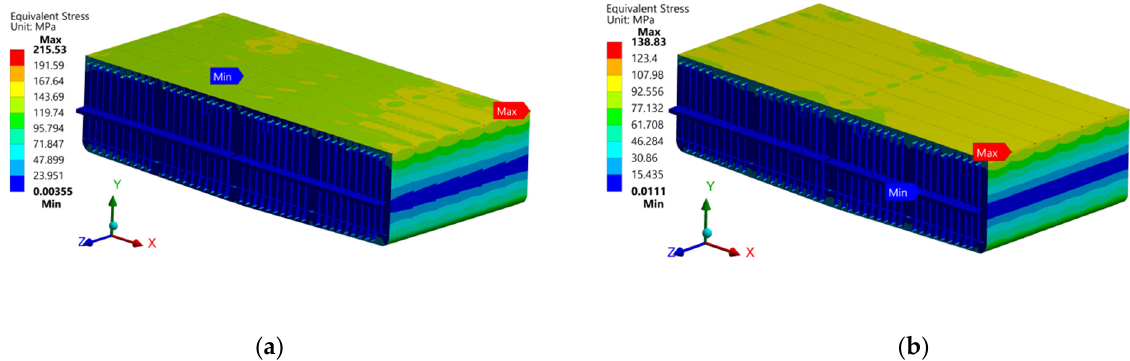
Figure 14. Results of von Mises stress distribution of the central tank generated by: ( a ) Sagging bending moment of 906.88 × 10 6 Nm and ( b ) Hogging bending moment of 599.10 × 10 6 Nm. Table 6. Results of the FEM model of the barge midship section.